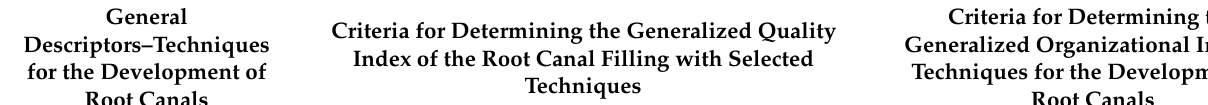
Table 3. The set of criteria adopted for the virtual contextual analysis concerning the selection of techniques for the development of root canals in endodontic